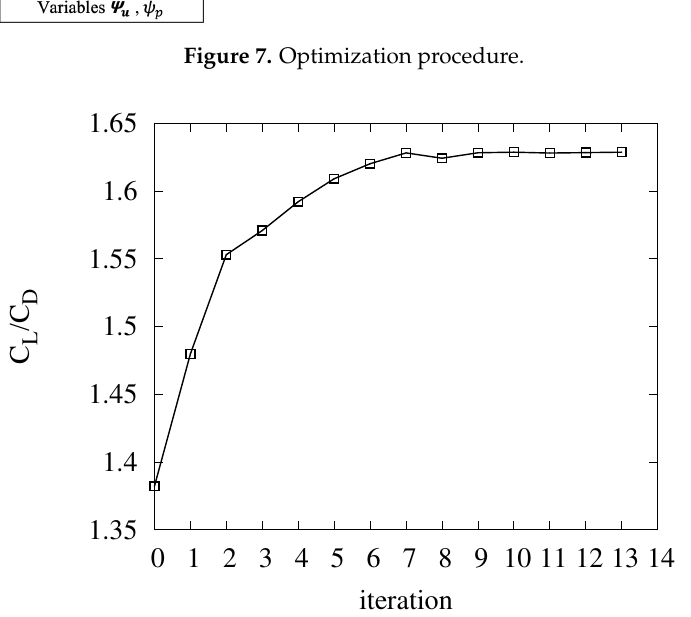
Figure 8. Iteration history of time-averaged lift-to-drag ratio C L / C D . Table 2. Change in time-averaged lift-to-drag ratio value by shape optimization procedure. Number of Iterations